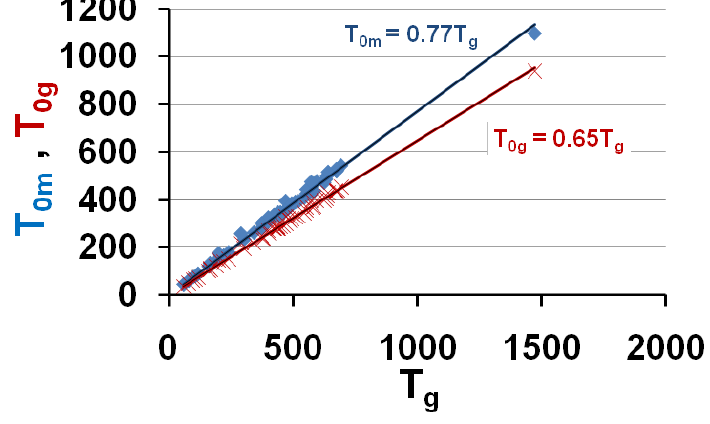
Figure 6. The calculated values of the free-volume disappearance temperatures T T are plotted versus T ; they are equal to the VFT temperatures T 0g g Figure 1. T = 0.77 T and T = 0.65 T . 0m g 0g g